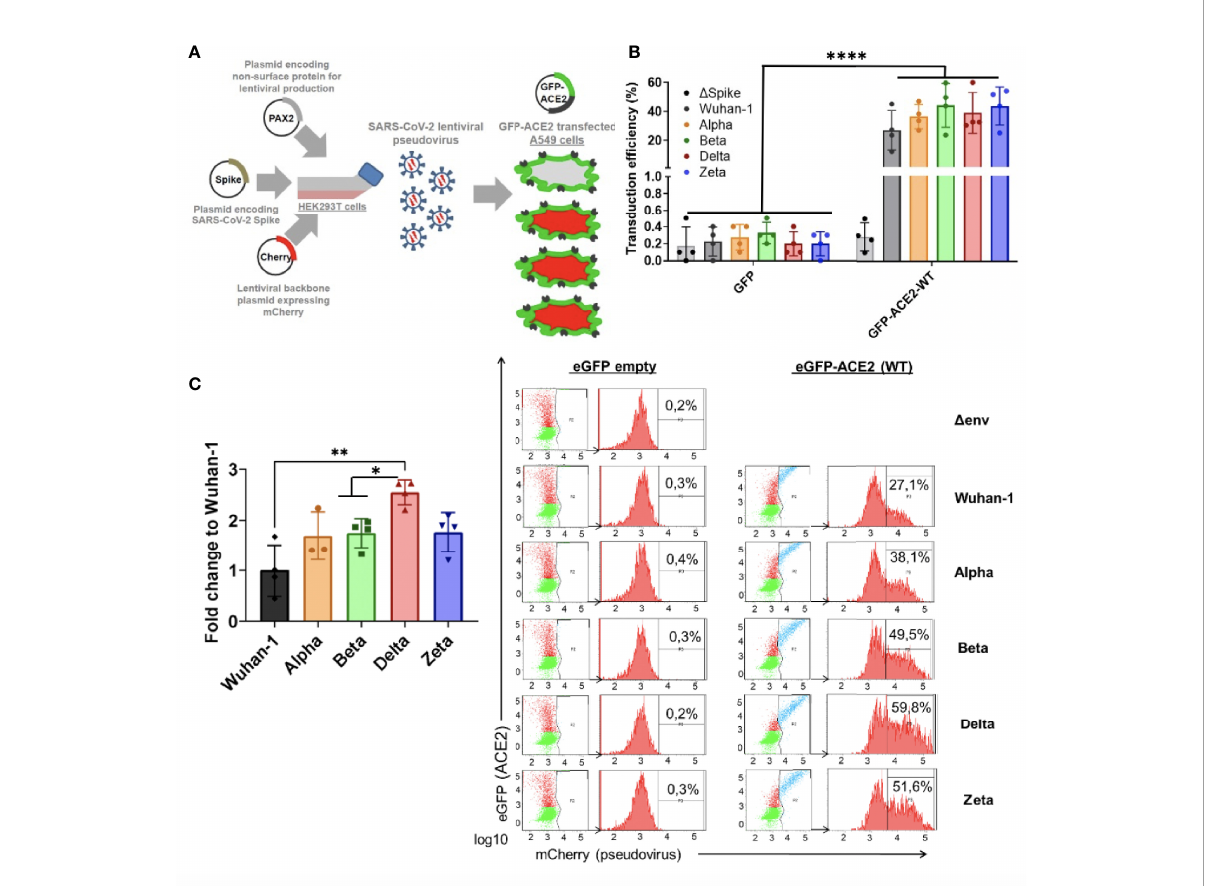
FIGURE 9 Differential SARS-CoV-2 infection is dependent on COVID19 variant-of-concern and ACE2 expression. (A) SARS-CoV-2 cell entry assay strategy: Lentiviral-based replication-defective pseudovirus were generated in HEK293T cells from lentiviral parental genes, SARS-CoV-2 Spike and encapsulating a mCherry reporter. Since the entry steps of the SARS-CoV-2 pseudovirions are governed by the coronavirus Spike protein at their surface, they enter cells in a similar fashion to native counterparts. A549 airway cells were transfected with exogenous GFP-hACE2 enabling SARS-CoV-2 pseudovirus to effectively infect the cells with mCherry reporter. Double-positive GFP/mCherry cells were quanti fi ed by fl ow cytometry to assess viral infection capacity. (B,C) Following the strategy described in A, A549 cells expressing GFP-hACE2 were assayed for cell entry by SARS-CoV-2 pseudovirus expressing either empty vector ( D Spike) or Spike protein corresponding to origin variant (Wuhan-1) or variants-of-concern Alpha, Beta, Delta or Zeta. A representative fl ow cytometry experiment is shown. Bars demonstrate mean and Standard Error of Mean while each data point represents a unique experiment; ****P < 0.0001; **P < 0.01; *P < 0.1 by two-tailed